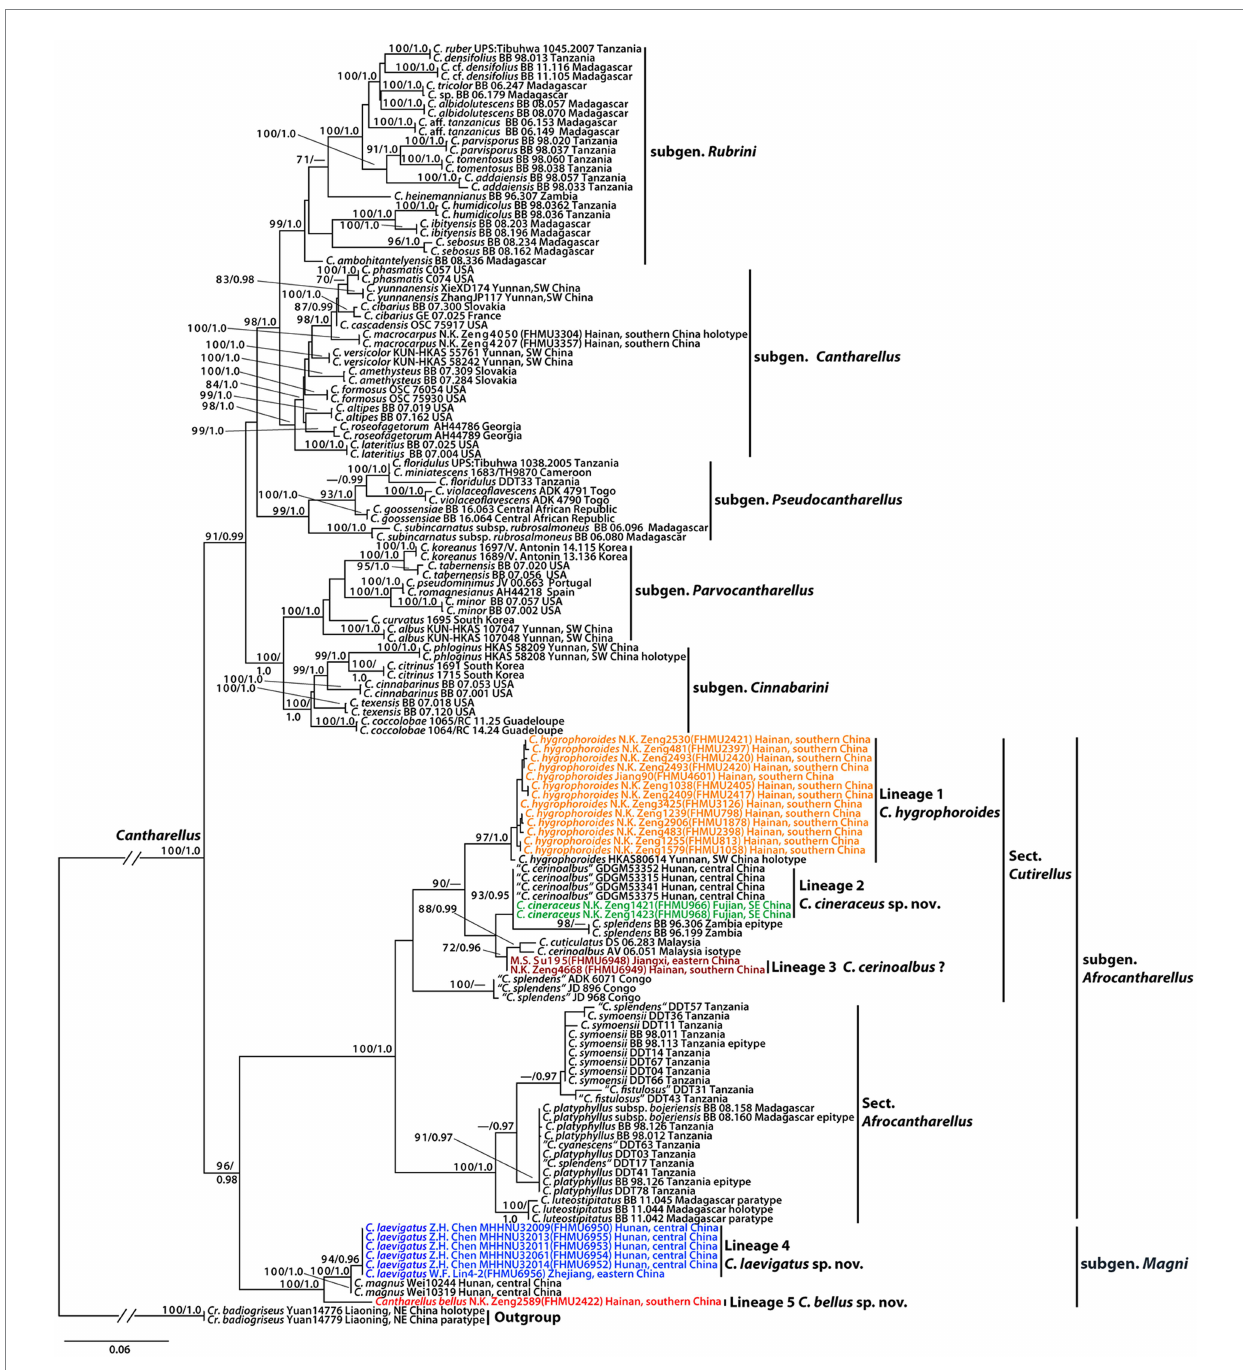
FIGURE 1 Phylogram of genus Cantharellus , with emphasis on subgenera Afrocantharellus and Magni , inferred from a two-locus (rDNA 28S, TEF1 ) dataset using RAxML. BS ( ≥ 70%) and PP ( ≥ 0.95) are indicated above the